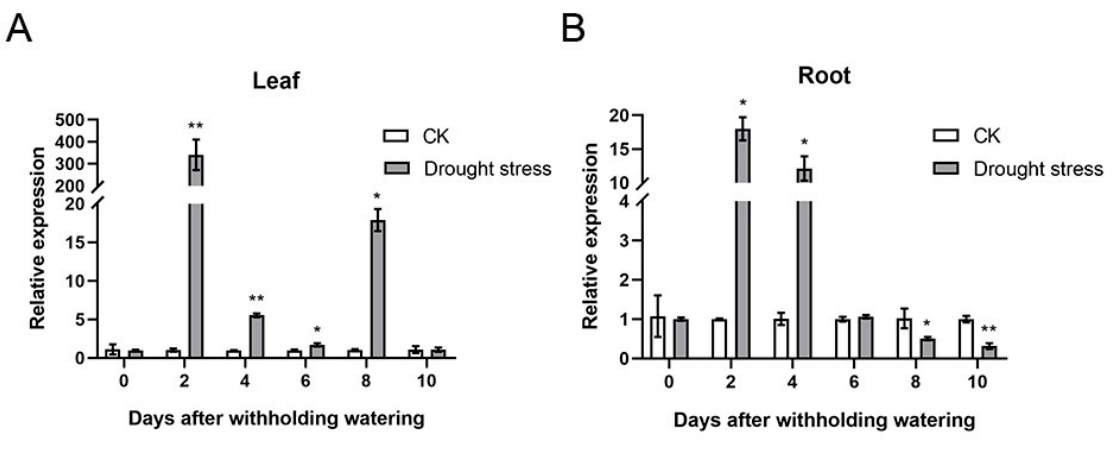
Figure 4. The transcript abundance of AcTS in areca leaves and roots under treatment ( n =